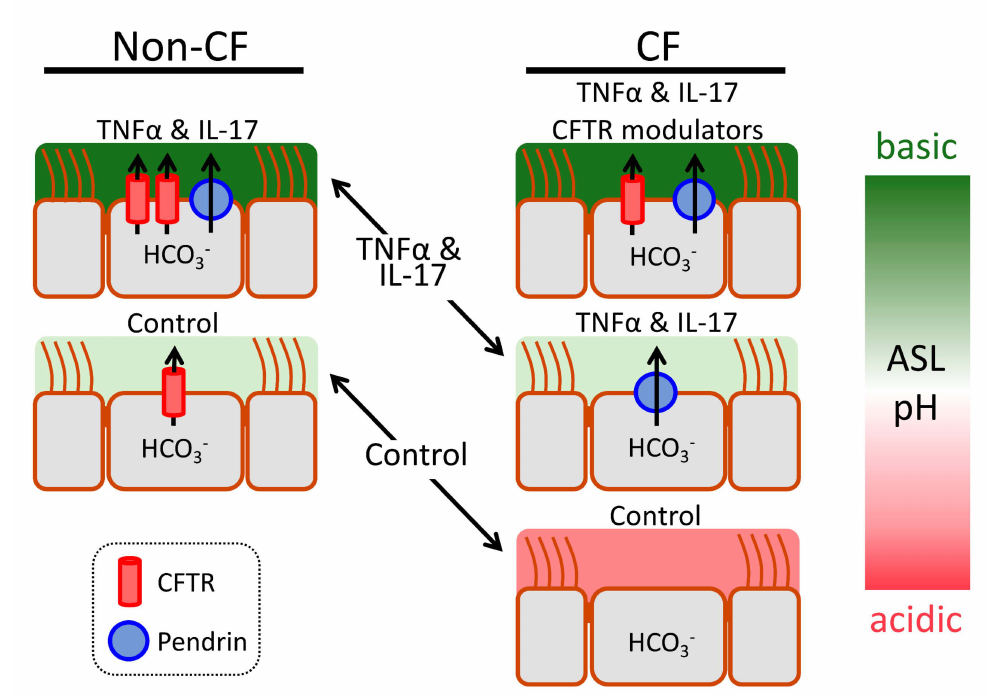
Figure 3. Inflammatory cytokines (IL-17/TNF α ) regulate pH ASL in human CF and non-CF airway epithelia. Control CF epithelia lack CFTR-mediated HCO 3 − secretion and have a lower pH ASL than control non-CF epithelia. IL-17/TNF α upregulate pendrin, an apical Cl − /HCO 3 −